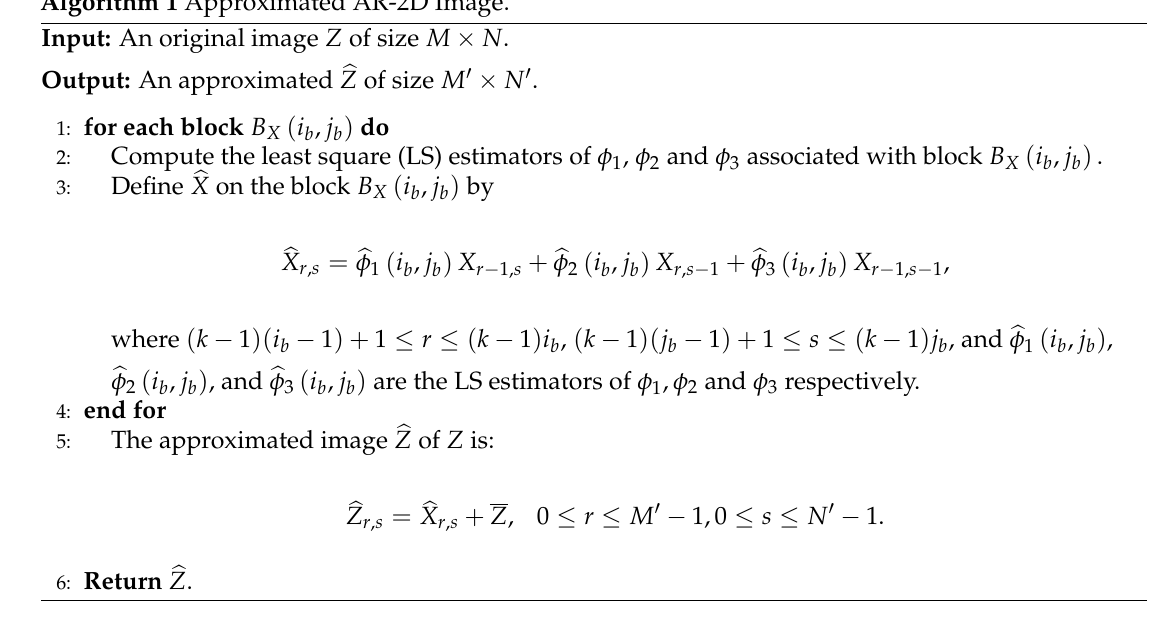
Algorithm 1 Approximated AR-2D